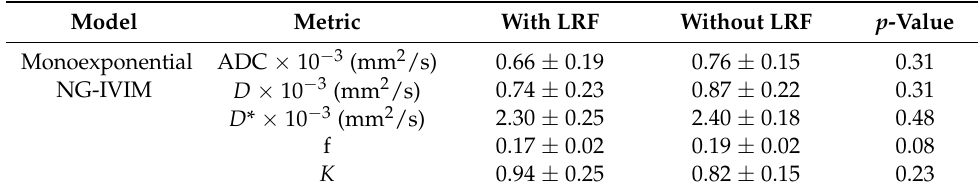
Table 2. ADC and NG-IVIM derived metric values.